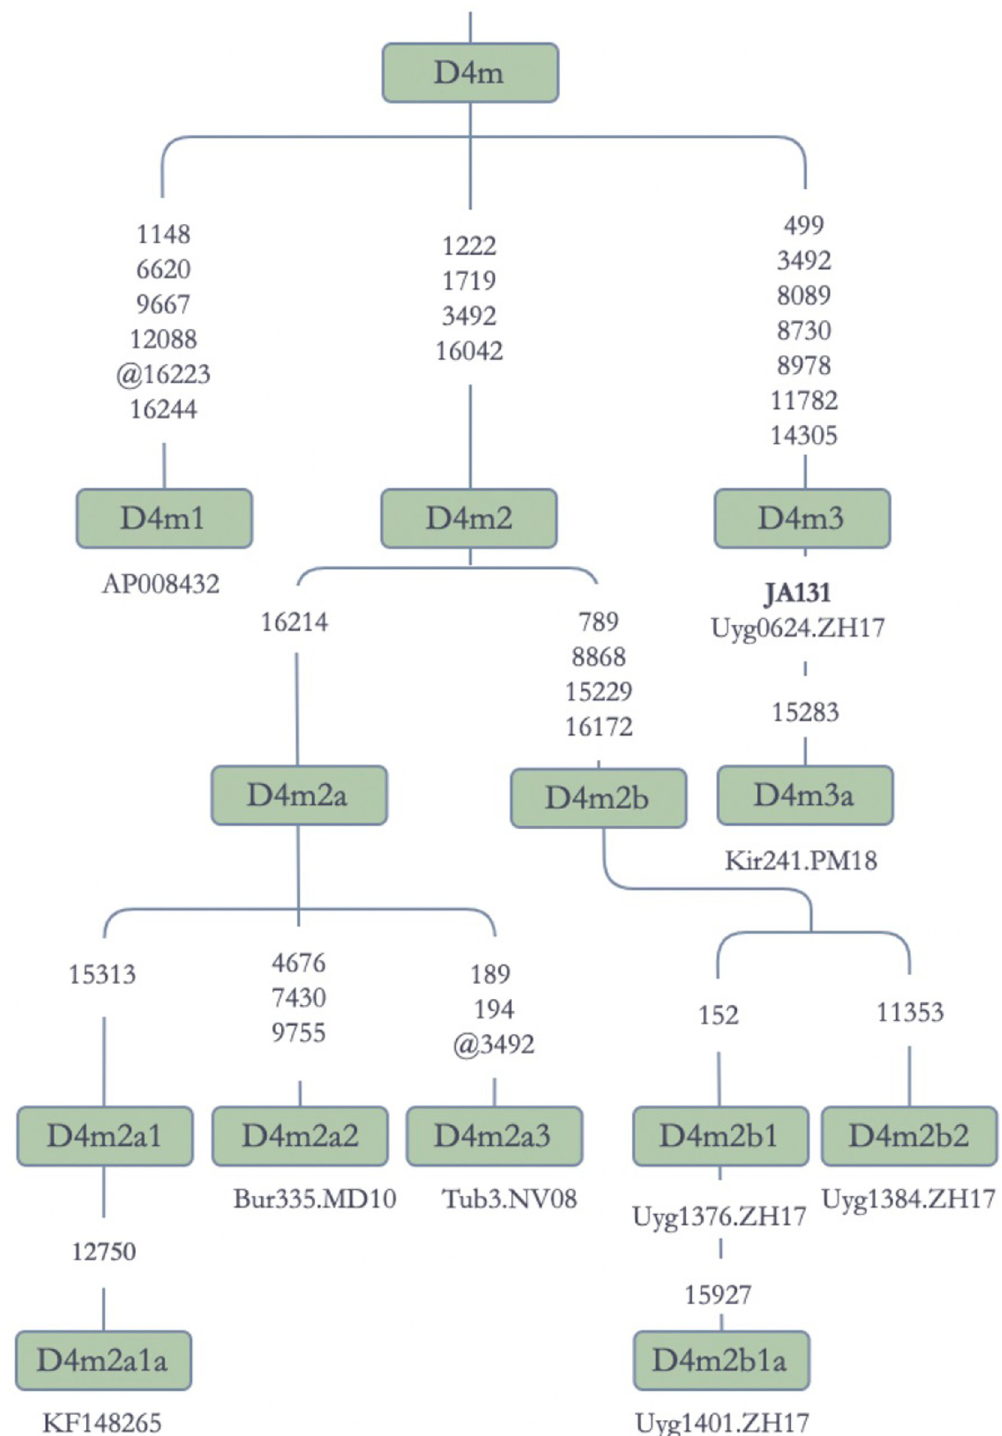
Fig 9. Schematic phylogenetic tree for the haplogroup D4m mitochondrial genomes. Note: Alt: Altaian; Bur: Buryat; Uyg: Uyghur; Kir: Kirghiz; Tib: Tibetan; Tub: Tuba/Tuva;. KF148265 (Even) and AP008432 (Japanese) were from the Phylotree Build 17.0